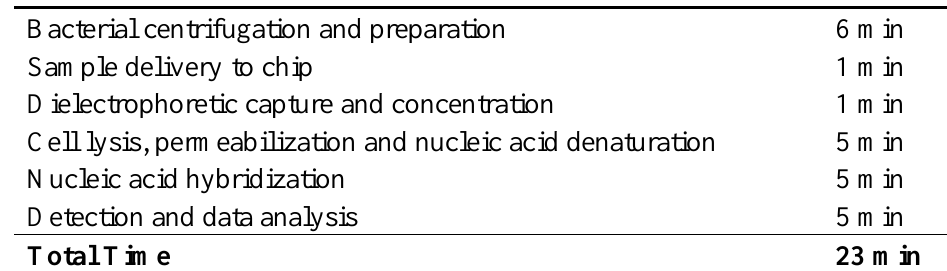
Table 1. Fluorescence resonance energy transfer assisted in situ hybridization (FRET-ISH) assay